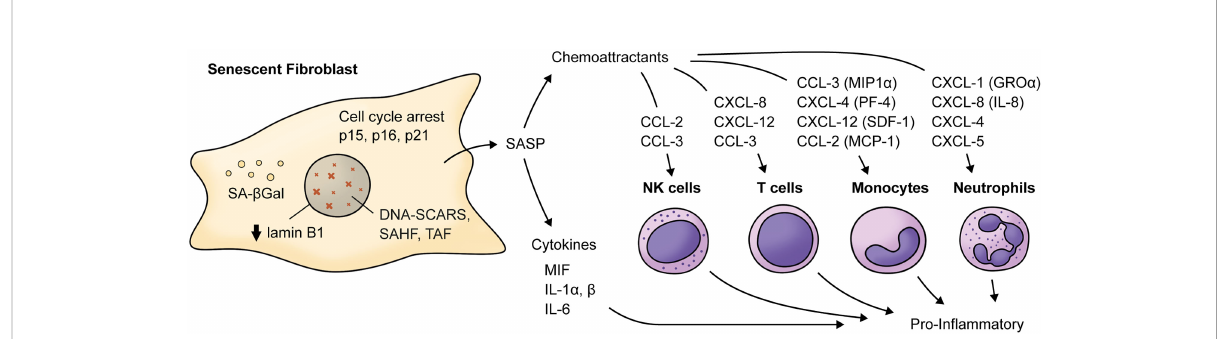
FIGURE 2 Main cytokines and chemokines elevated in the Senescence-Associated Secretory Phenotype by senescent fi broblasts. Senescent fi broblasts are characterized by cell-cycle arrest mainly related to increased levels of cyclin-dependent kinases inhibitors (p15 INK4b , p16 INK4a , p21 CIP1 ), decreased levels of lamin B1 and the presence of a SASP characterized by increased levels of cytokines and chemokine such as IL-6, MIF, IL-1 a and b which acts as pro-in fl ammatory cytokines. For example, chemokines such as CXCL-1, CXCL-8, CXCL-5, and CXCL-4 can be chemoattractants for neutrophils. CCL-3, CCL-4, CXCL-12, and CCL-2 can be chemoattractants for monocytes, and IL-8, CXCL-12, and CCL-3 can act as a chemoattractant for T cells. Notably, CCL-2 and CCL-3 can also attract NK cells. MIF, macrophage migration inhibitory factor; MIP1 a , macrophage in fl ammatory protein 1-alpha; MCP-1, monocyte chemoattractant protein 1; CXCL-5, C-X-C motif chemokine 5; PF-4, platelet factor 4; SDF-1, stromal cell-derived factor 1; SAHF, Senescence-associated heterochromatin foci; TAF, Telomere-associated DDR foci; DNA-SCARS, DNA segments with chromatin alterations reinforcing senescence. SA- b Gal, Senescence-associated beta galactosidase; GRO a , growth-regulated alpha